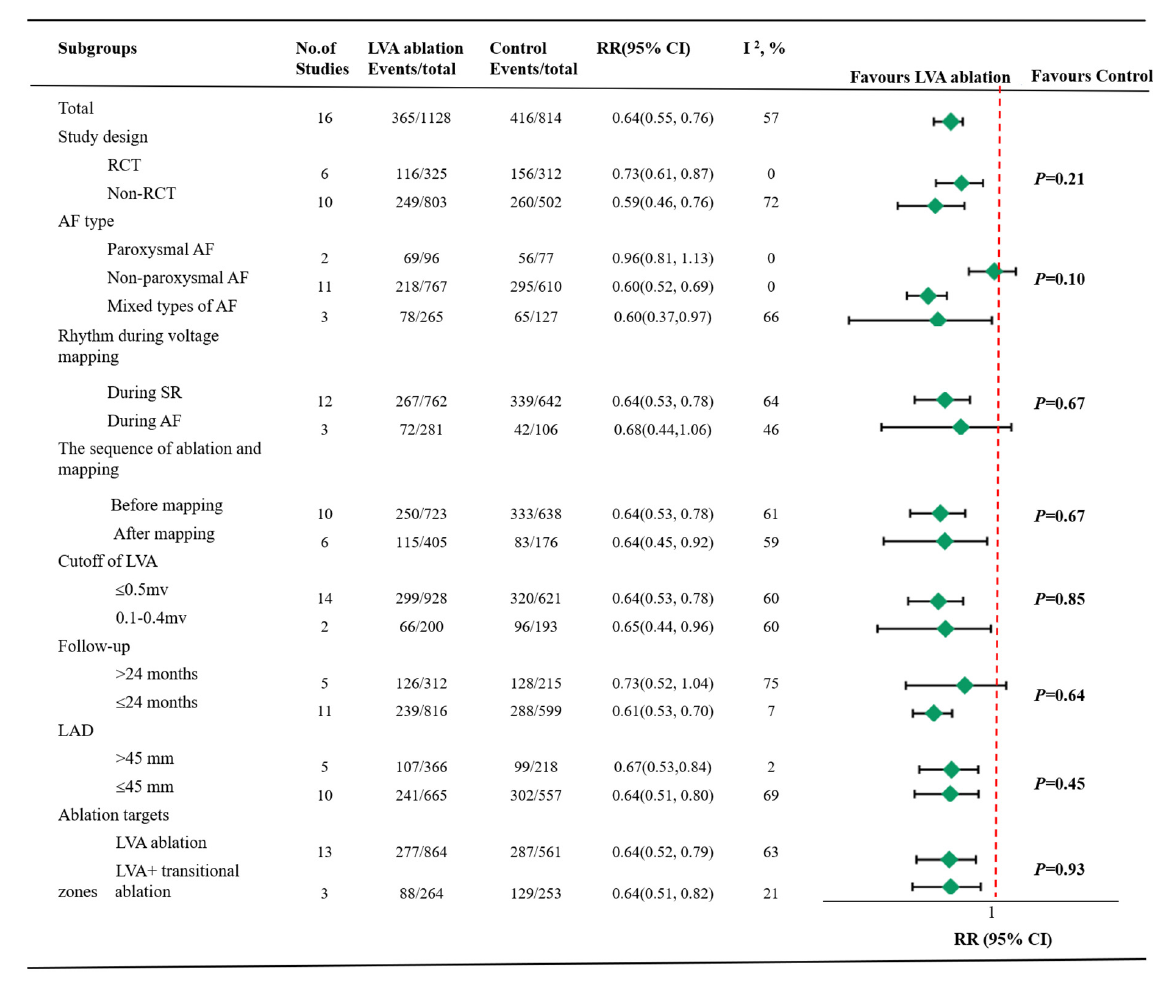
FIGURE3 Pooled summary results by subgroups. LVA, atrial low-voltage areas; RR, risk ratios; CI, confidence intervals; RCT, randomized controlled trials; AF, atrial fibrillation; SR, sinus rhythm; LAD, left atrial